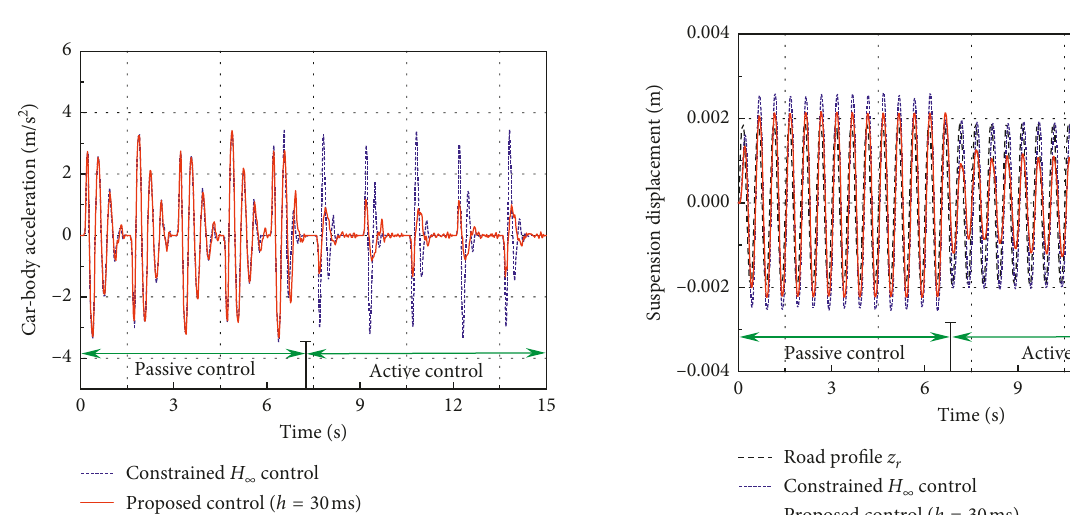
Figure 11: Hardware results of suspension displacement under square wave signal.